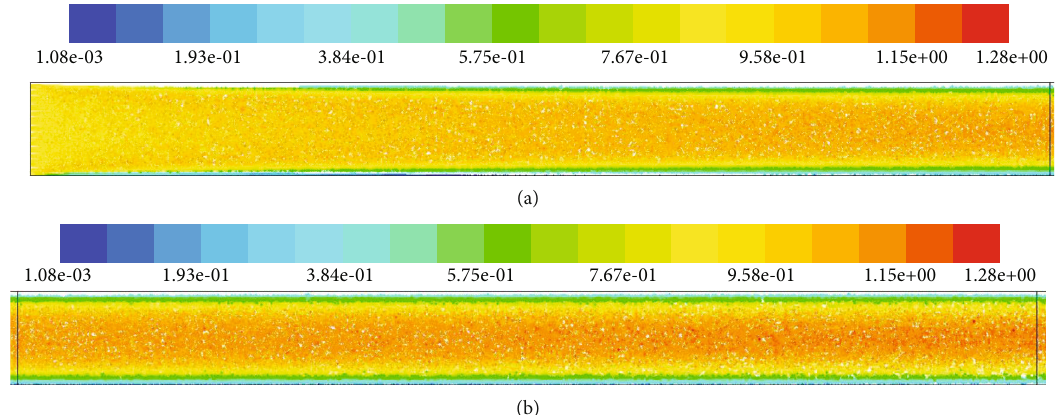
≤ 20 mm fracture segment; (b) 20 mm ≤ X 1